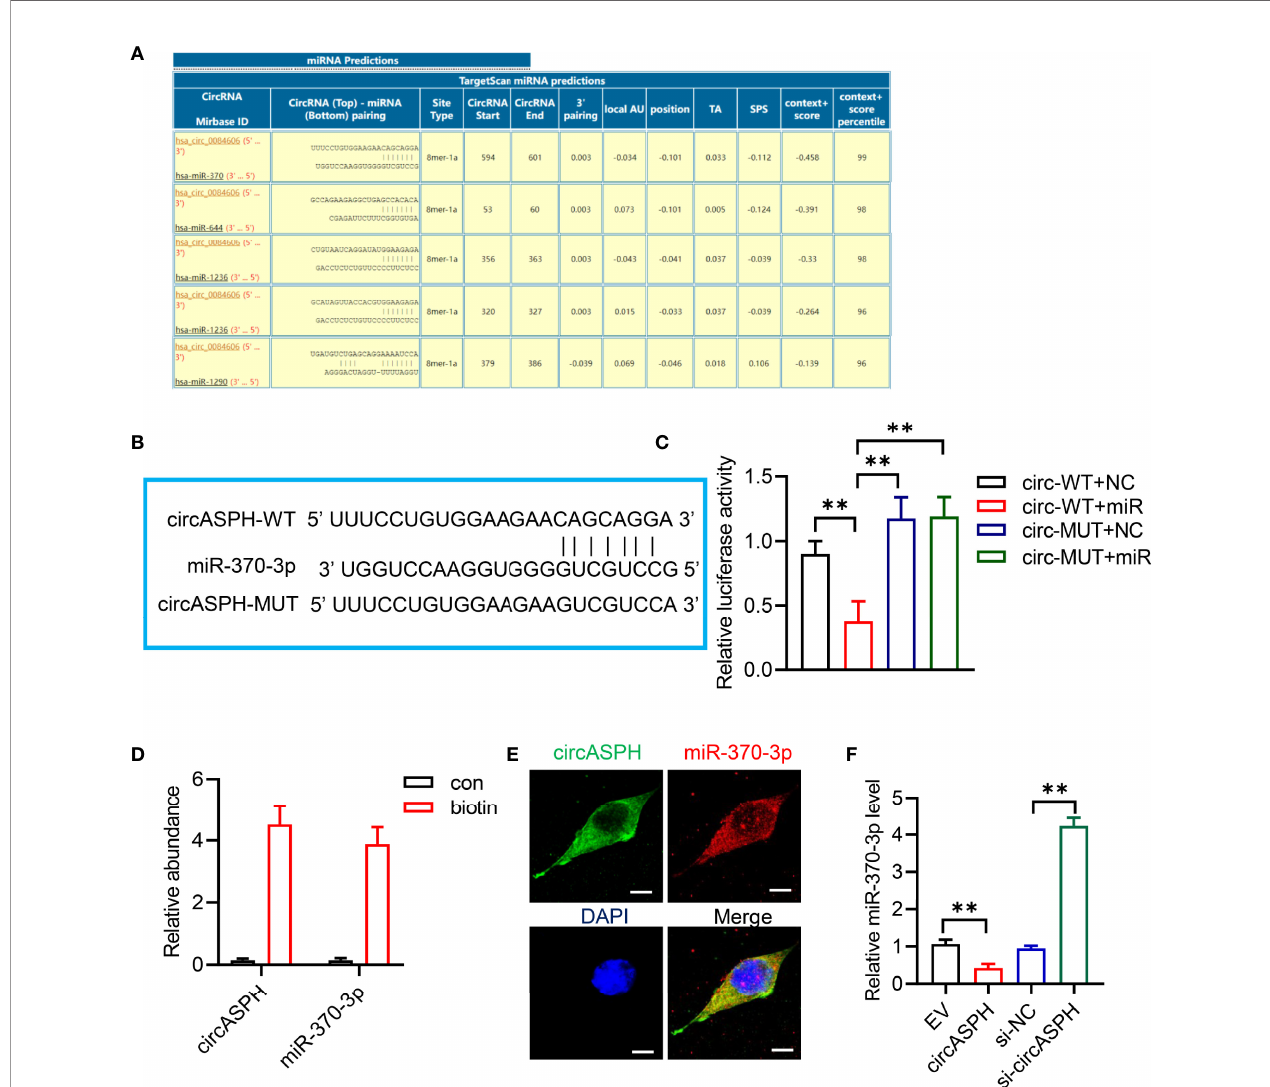
FIGURE 3 | CircASPH sponged miR-370-3p. (A) Score list for the circInteractome of predicting miRNAs sponged by circASPH. (B) Predicted binding sites between circASPH and miR-370-3p. (C) Dual-luciferase reporter assay showed that the co-transfection of WT and mimic miR-370-3p markedly decreased the luciferase activity. (D) MiR-370-3p was abundantly pulled down by a circASPH probe. (E, F) Images of circASPH and miR-370-3p co-localized in the cytoplasm; scale bar, 20 m m. *p < 0.05, **p < 0.01, ***p <